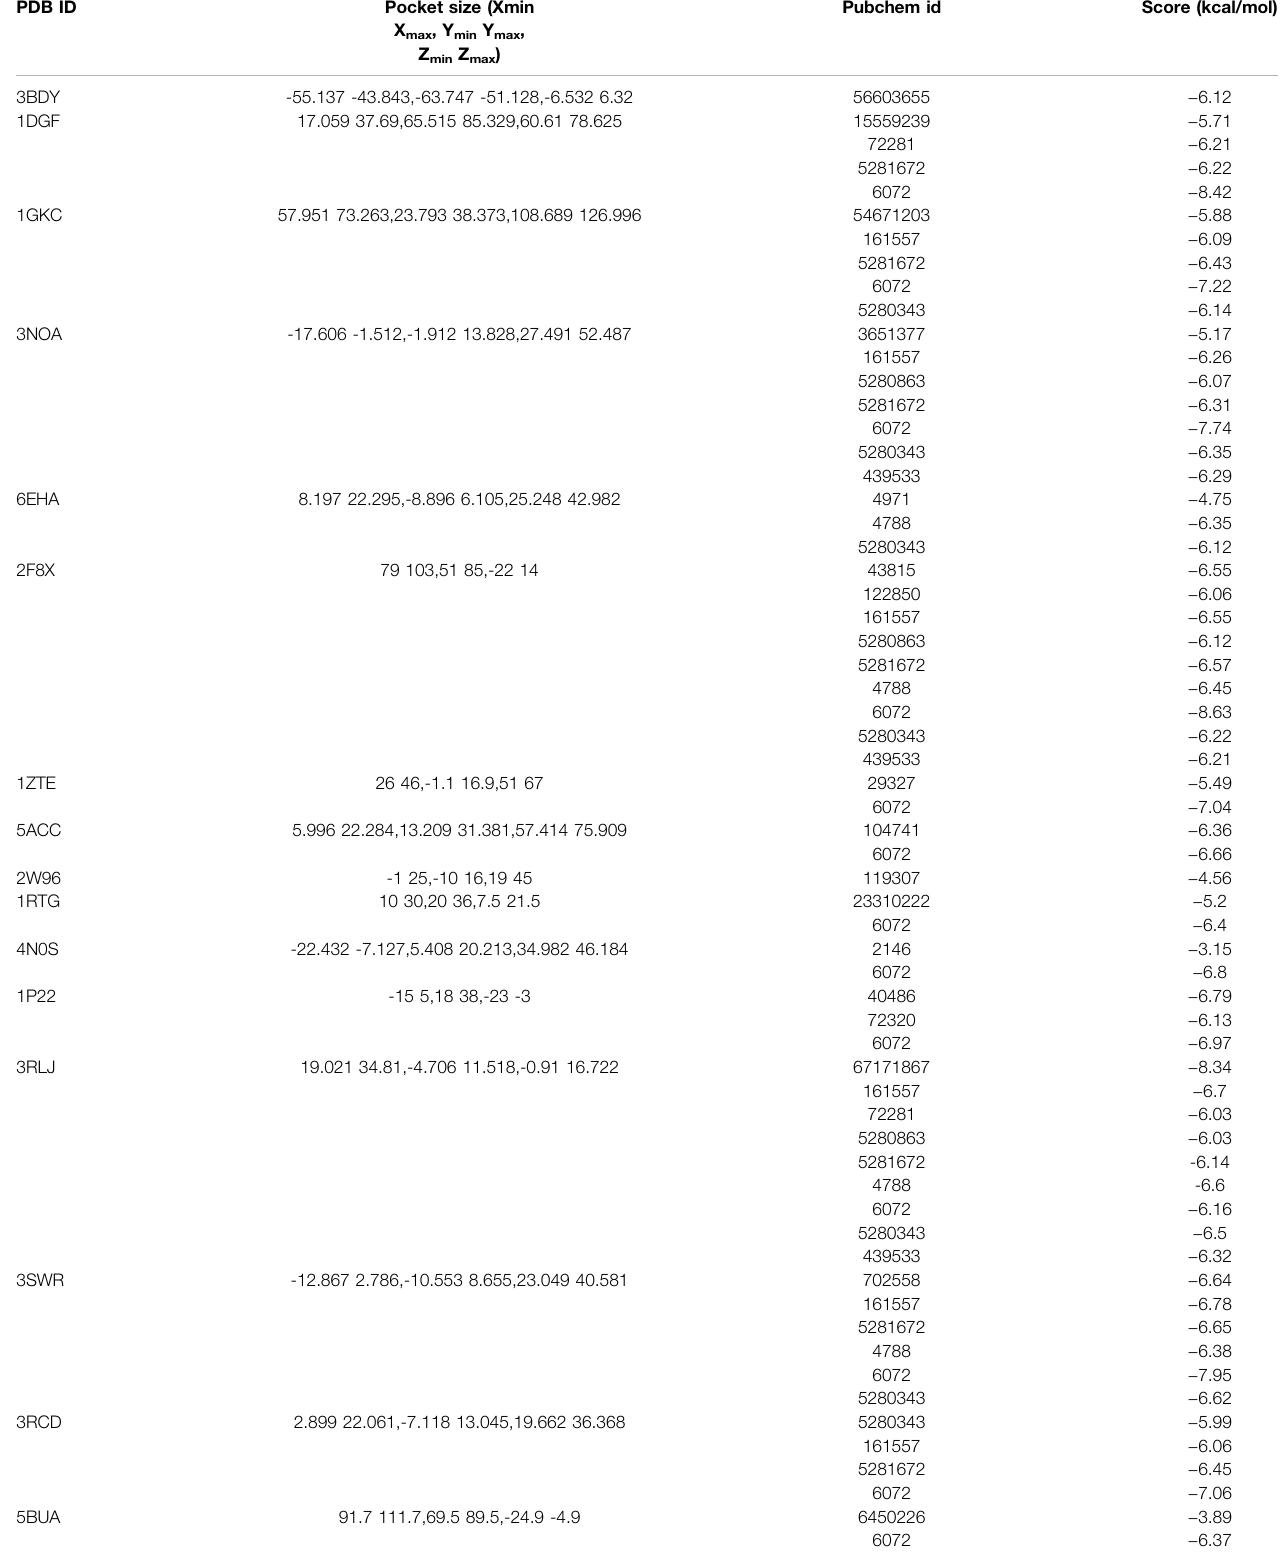
TABLE 4 | Molecular docking of potentially toxic components of vine